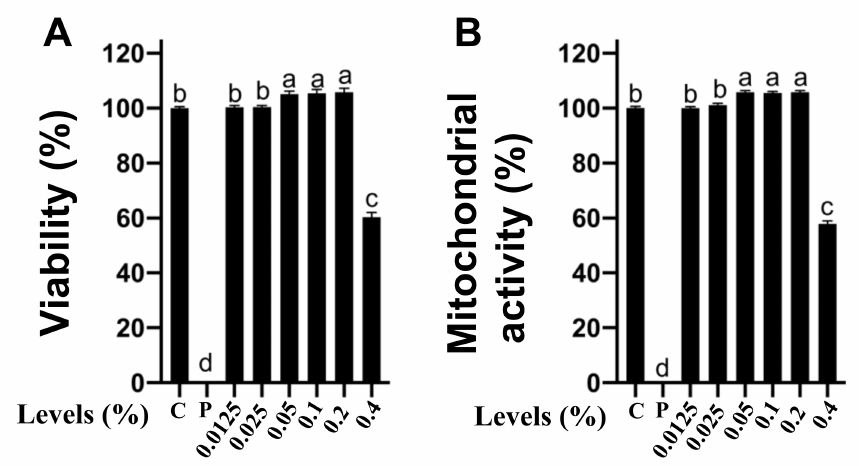
Figure 1. Cytotoxicity analysis of CNMs toward intestinal epithelial cells. LDH assay ( A ) and MTT assay ( B ) of IPEC-J2 cells in the presence of various concentrations of CNMs. Positive control was Triton X-100. Data are the means ± SEM of three independent experiments. Means with different lowercase letters differ significantly ( p < 0.05). C, negative control; p , positive